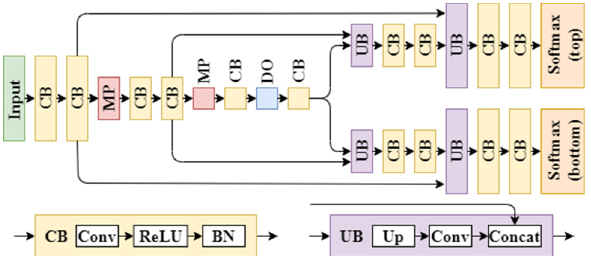
Figure 2. Network Architecture for the experiments